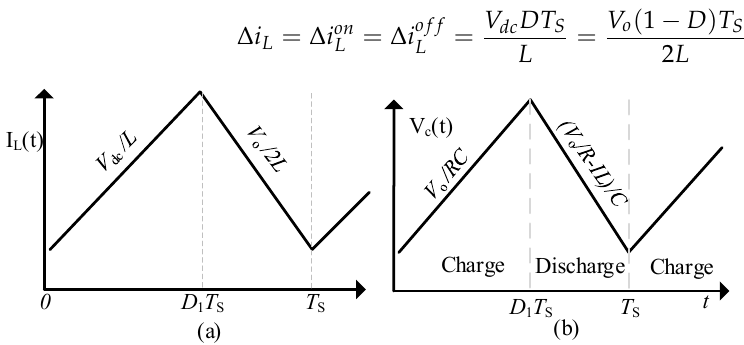
Figure 8. CCM operation ( a ) inductor current and ( b ) output capacitor voltage.